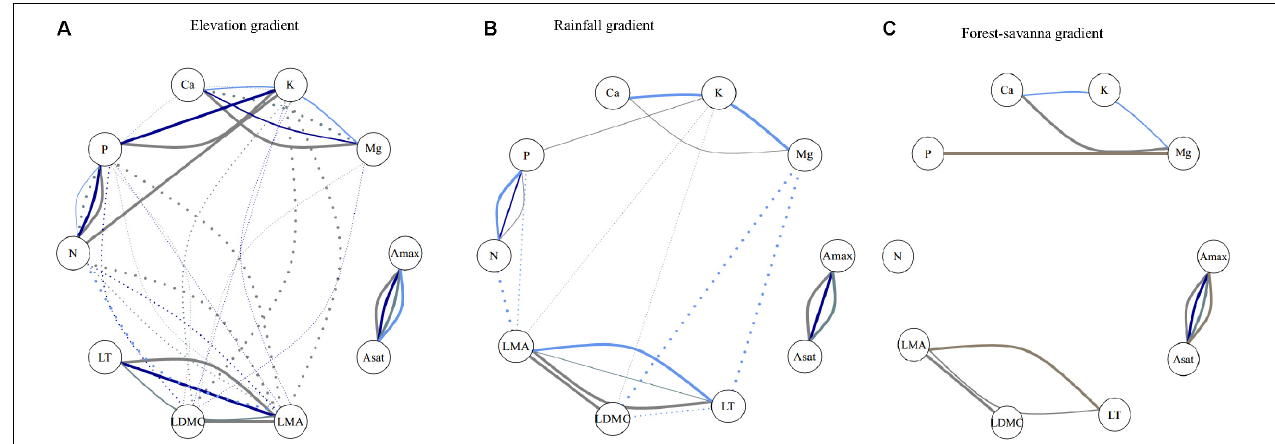
FIGURE 2 | Kendall’r correlation network of leaf traits (inside the circles) at the different ecological levels for the three studied abiotic gradients. Line colors represent the different ecological levels: gray: within-species; darkblue: species; bluegray: genus; lightblue: family: brown: plot. Positive associations are depicted by solid lines, and negative associations are in dotted lines. Line width represents strength of statistical significance, with wide lines representing p < 0.001 and thinner p < 0.05 (after Holm’s correction). Full Kendall r association values are shown in Supplementary Figures S3–S5 . (A) Elevation gradient, (B) rainfall gradient, and (C) forest-savanna